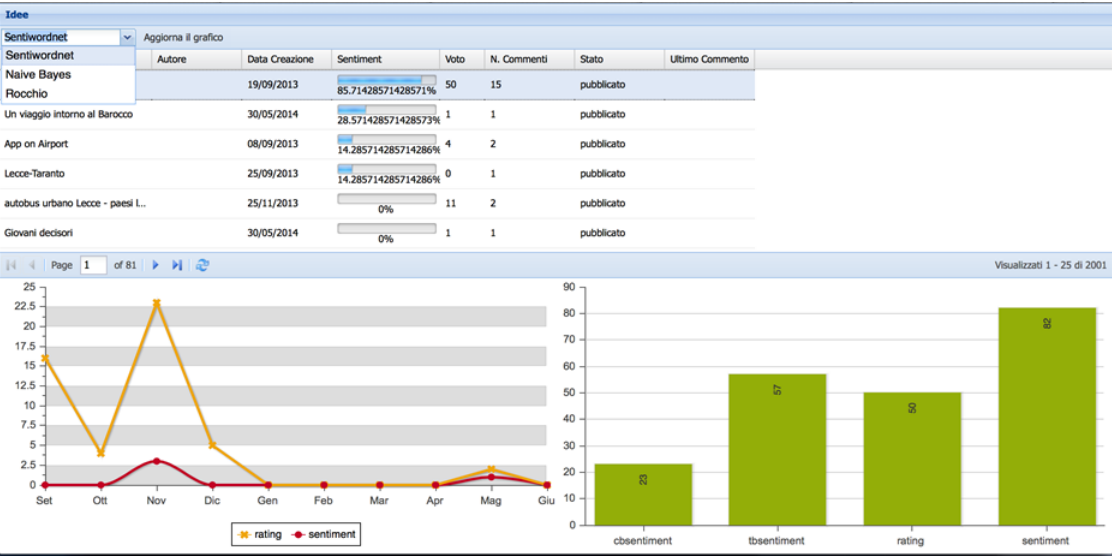
Figure 2. Sentiment analysis